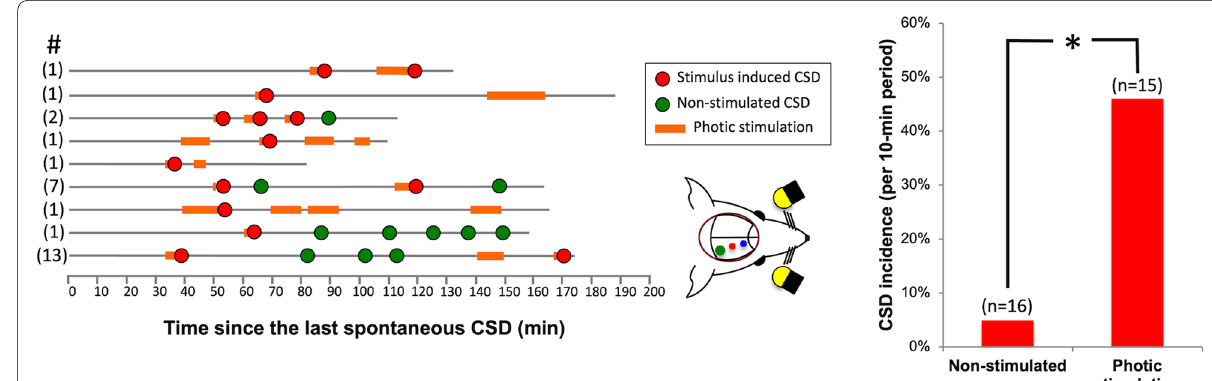
fig. 2 Priming the occipital cortex with ouabain increased the incidence of photic stimulation‑induced CSDs. Each horizontal line represents continuous recording from one mouse primed with 0.1 mM ouabain and then subjected to 1‑min on and off cycles of photic stimulation at 8–12 Hz for 10 min except a few that lasted a bit shorter or longer due to interventions needed (e.g. for clearing the airway) or timing errors in stimulator. Stimulation started after at least a 30‑min silent period without any CSD. The number of ouabain‑induced CSDs prior to starting stimulation is given before each line in parentheses. Stimulation (labeled orange) was stopped when a CSD was triggered (red circles). Green circles depict the occasional CSDs unrelated to stimulation. Bar graph shows that the CSD incidence was significantly higher (* p < 0.001, Chi‑square test) during photic stimulation compared to the non‑stimulated periods. Only positive experiments are displayed on the left to simplify viewing of the flow charts by omitting the negative experiments ( n 6), but statistical analysis on the right included all animals regardless of the stimulation = effectiveness (15 mice) and compared them to 16 non‑stimulated mice treated with 0.1 mM ouabain. Because the CSD incidence was very low in controls, it was not suitable for illustration (i.e. 16 lines mostly with no